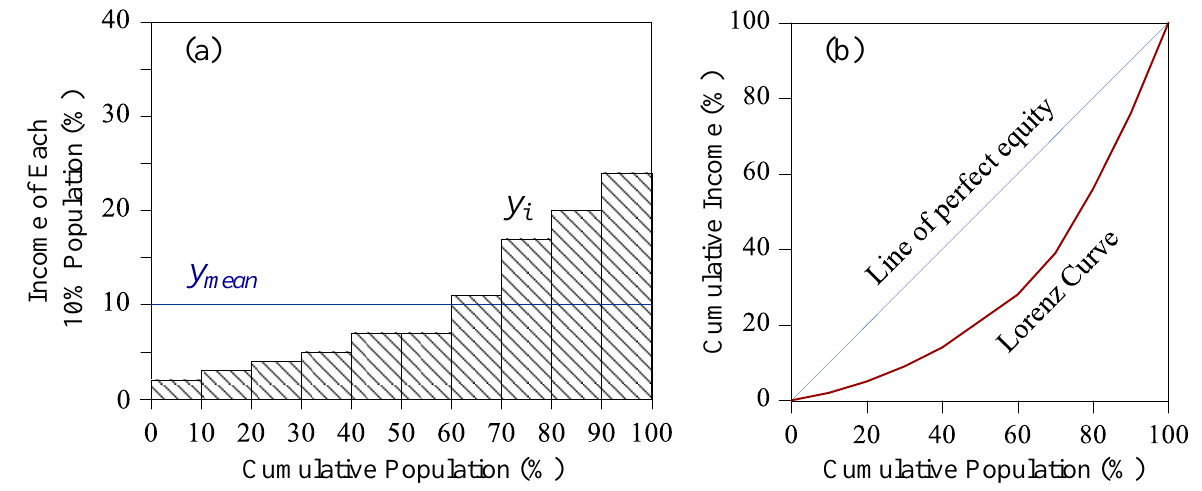
Figure 3. Example of the derivation of a Lorenz curve: ( a ) income of each 10% of the population arranged in a nondecreasing order and ( b ) comparison of the Lorenz curve and the line of perfect equity.